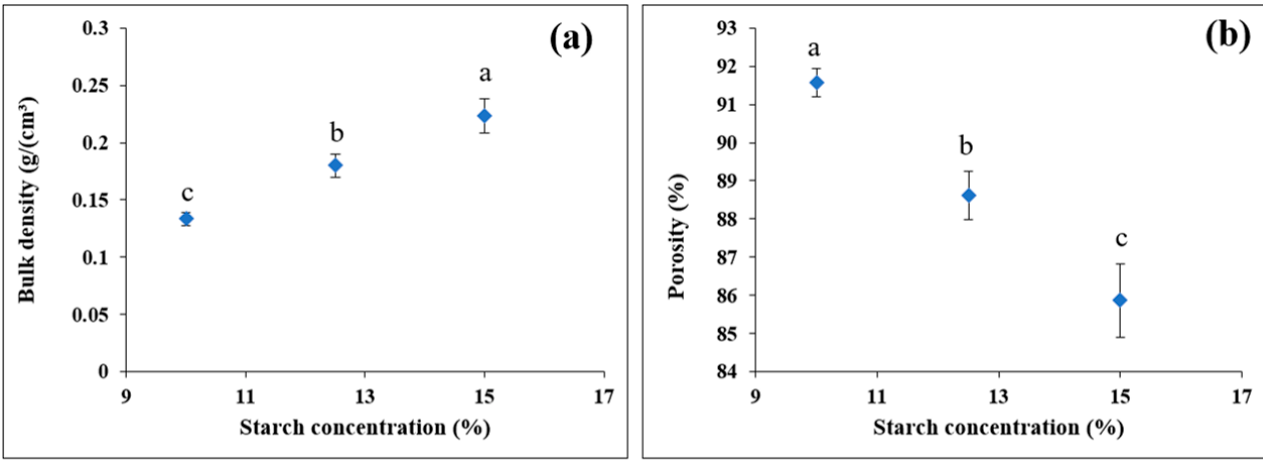
Figure 5. ( a ) Bulk density and ( b ) porosity of 3D-printed starch beads as a function of starch concentration (N = 3).